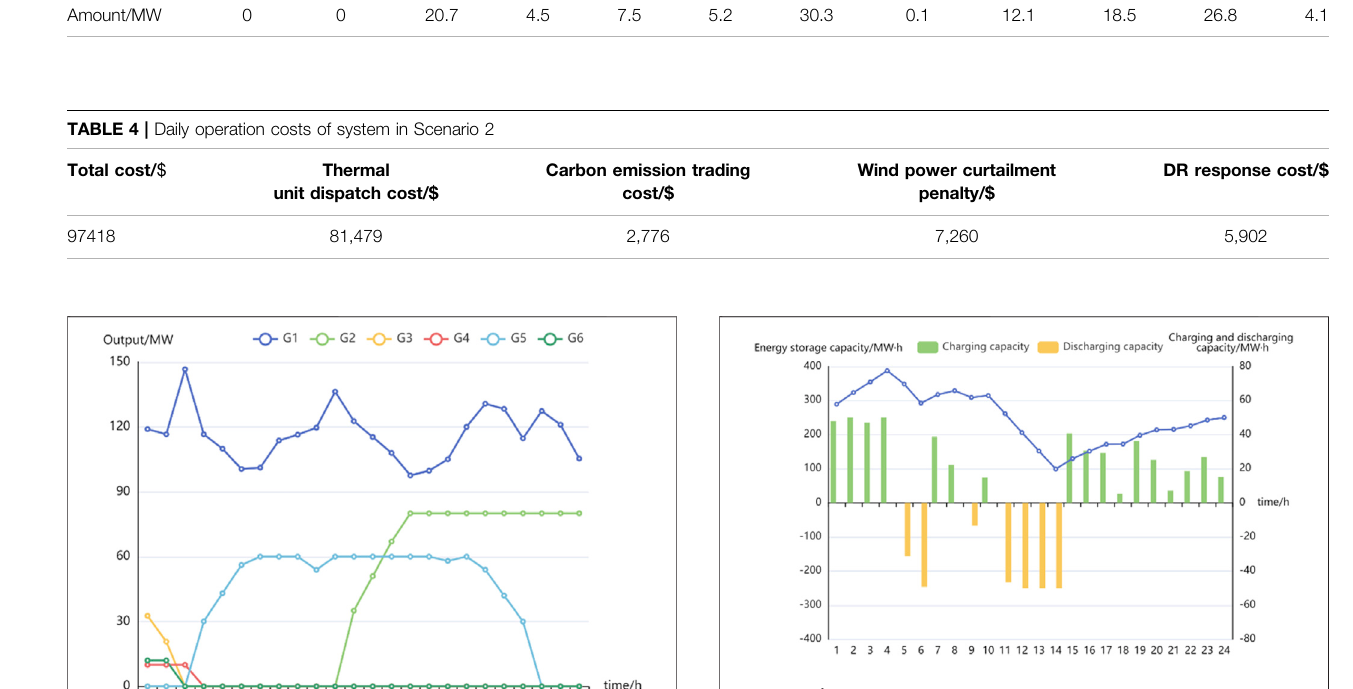
FIGURE 7 | Variation of ES capacity at each period in Scenario